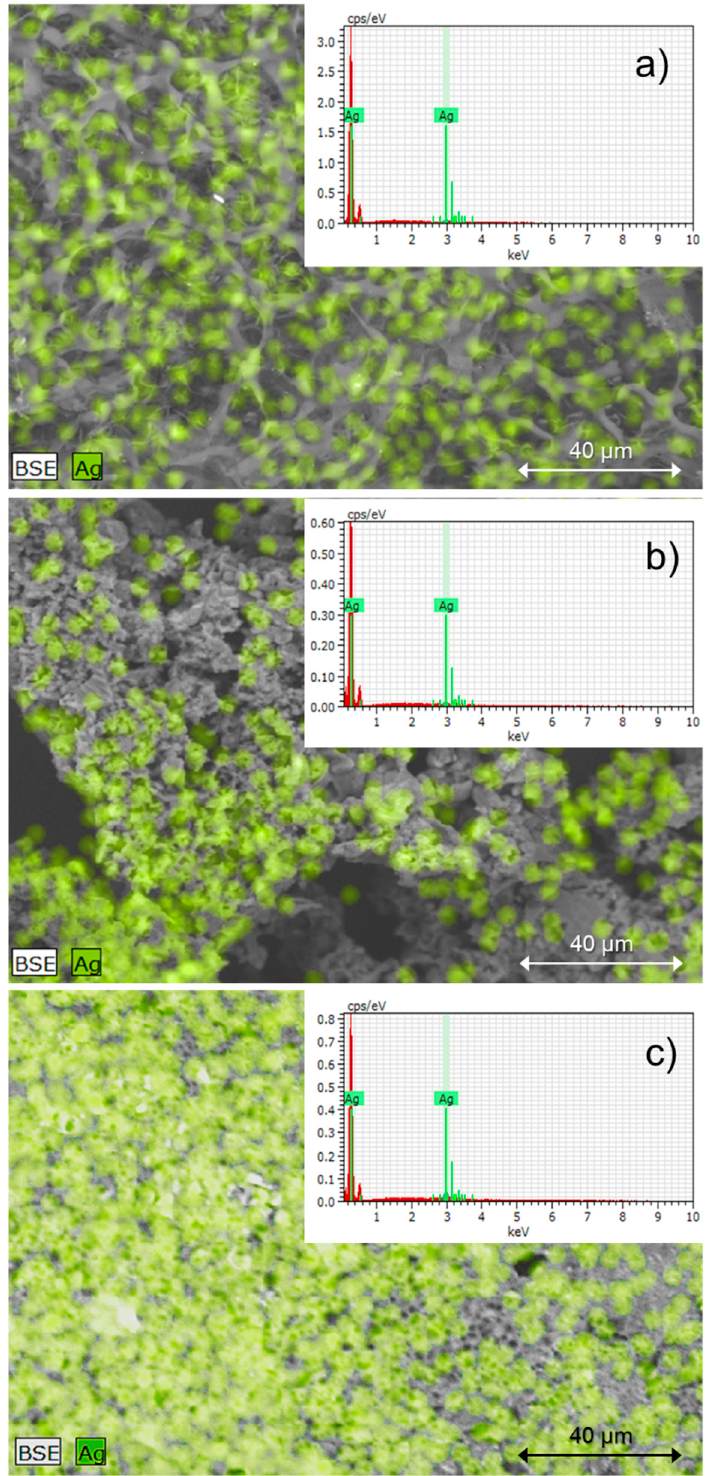
Figure 4. The EDS-SEM images of freeze-dried 1-week-old silver nanoparticle colloids with silver distribution and confirmation of its presence obtained by: ( a ) classical method (AgNPs chemical); ( b ) biogenic method using potato waste (AgNPs potato); ( c ) biogenic method using parsley waste (AgNPs parsley), magnification ×1000.